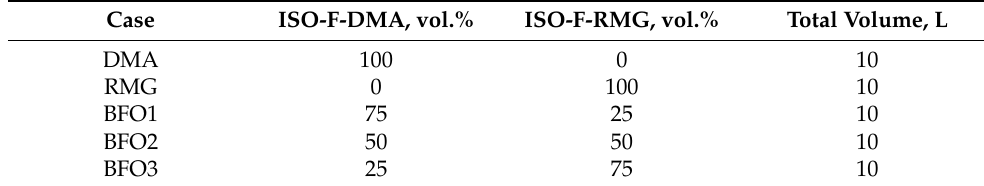
Table 1. Compositions of blends used in ultrasound